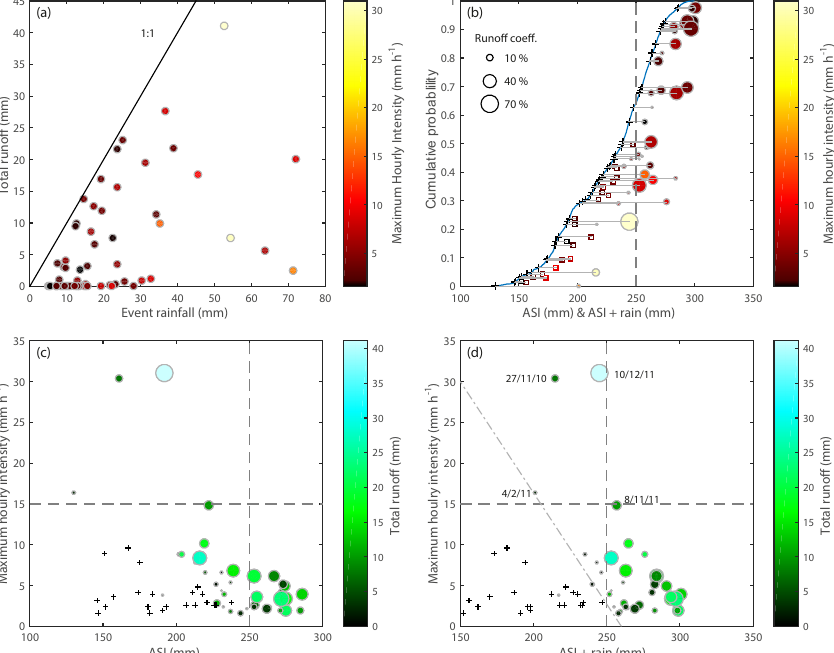
Figure 5. Thresholds of runoff mechanisms at RBF. (a) Event rainfall vs. event total runoff, colours indicating the highest hourly rainfall intensity. (b) The impact of five factors together, including the cumulative curve of the distribution of soil water storage as observed through the study period, ASI, ASI + Rain; colour shows the peak hourly rainfall intensity ( I peak ) and the size of the bubbles shows the event runoff coefficient. (c) ASI vs. the peak hourly rainfall intensity ( I peak ), and the size of the bubbles shows the event runoff coefficient and colour shows event total runoff. (d) ASI + Rain vs. the peak hourly rainfall intensity ( I peak ), and the size of the bubbles shows the event runoff coefficient and colour shows event total runoff. Note that ASI is the antecedent soil water storage (mm) in the top 60cm of the soil at the AWS at the beginning of the event.